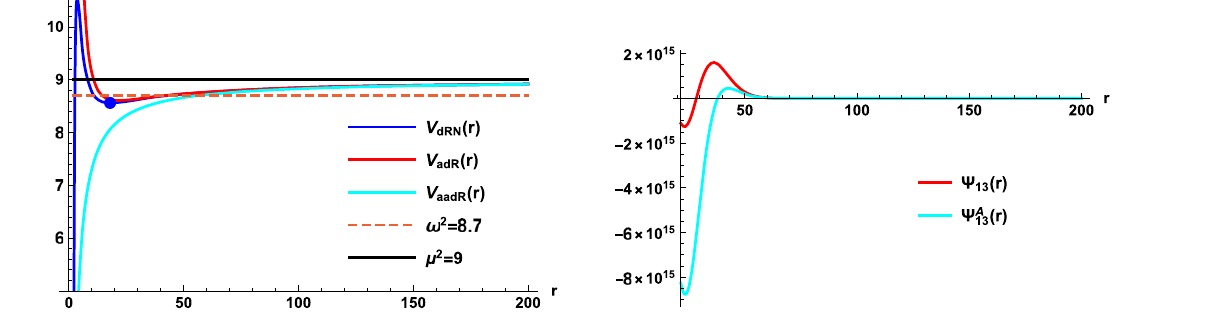
( = 0 . 1 ) < ω does not satisfy the superradiance condition. (Right) ω c Far-region scalar function (cid:17) 13 ( r ) and its asymptotic form (cid:17) A functions of r ∈ [ 21 . 5 , 200 ] represent quasibound states ( r ) > 0. We note that aadR